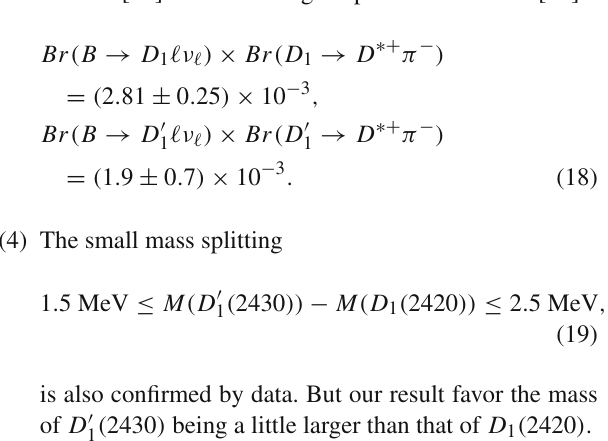
Fig. 5 The calculated mixing angle θ along with the parameter λ , with new setting of quark mass parameters ) ( θ = ± 90 ◦ ), where the inversion point M ( D 1 ) = M ( D (cid:3) 1 mixing angle is large and far away from the − 35 . 3 ◦ in heavy quark limit. And the large mixing angle leads to the solution of the ‘1 / 2 vs 3 / 2’